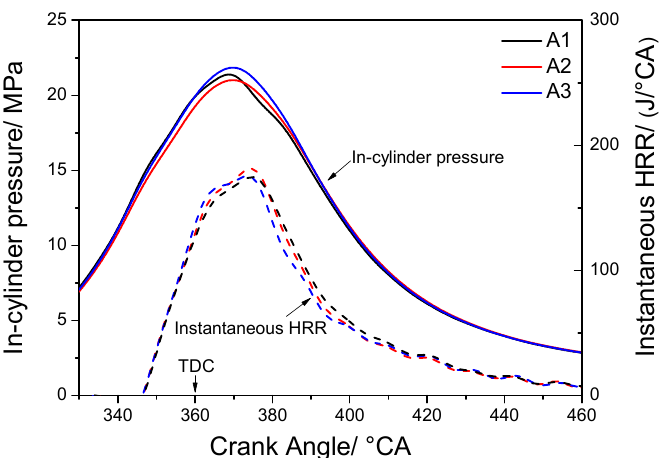
Figure 8. Cylinder Pressures and HRR for three combustion chambers at inlet pressure of 460 kPa.